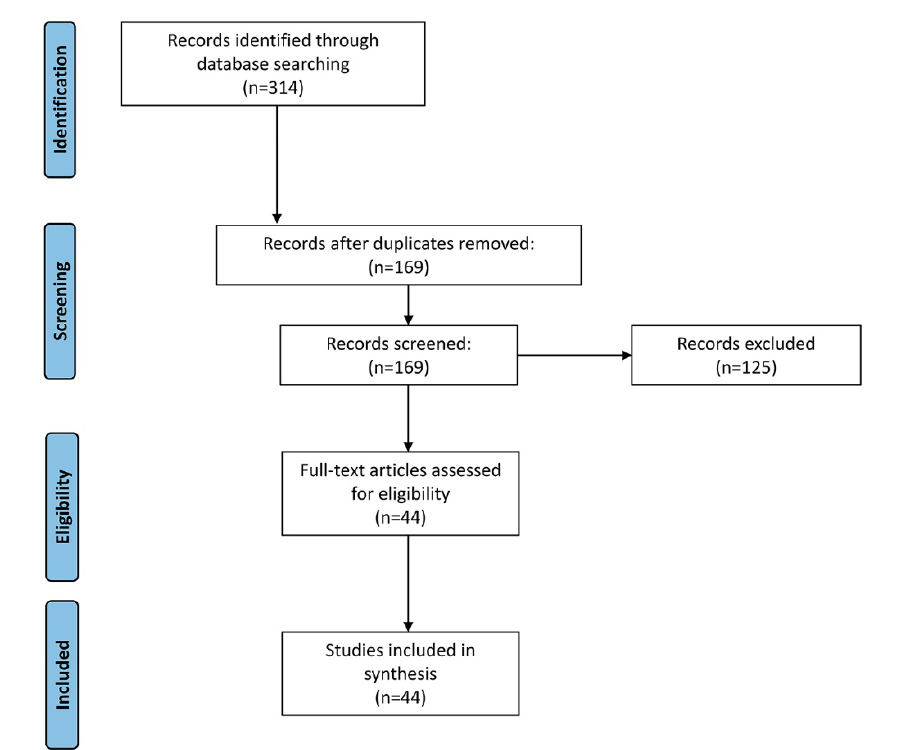
Figure 1 Flow diagram of article selection